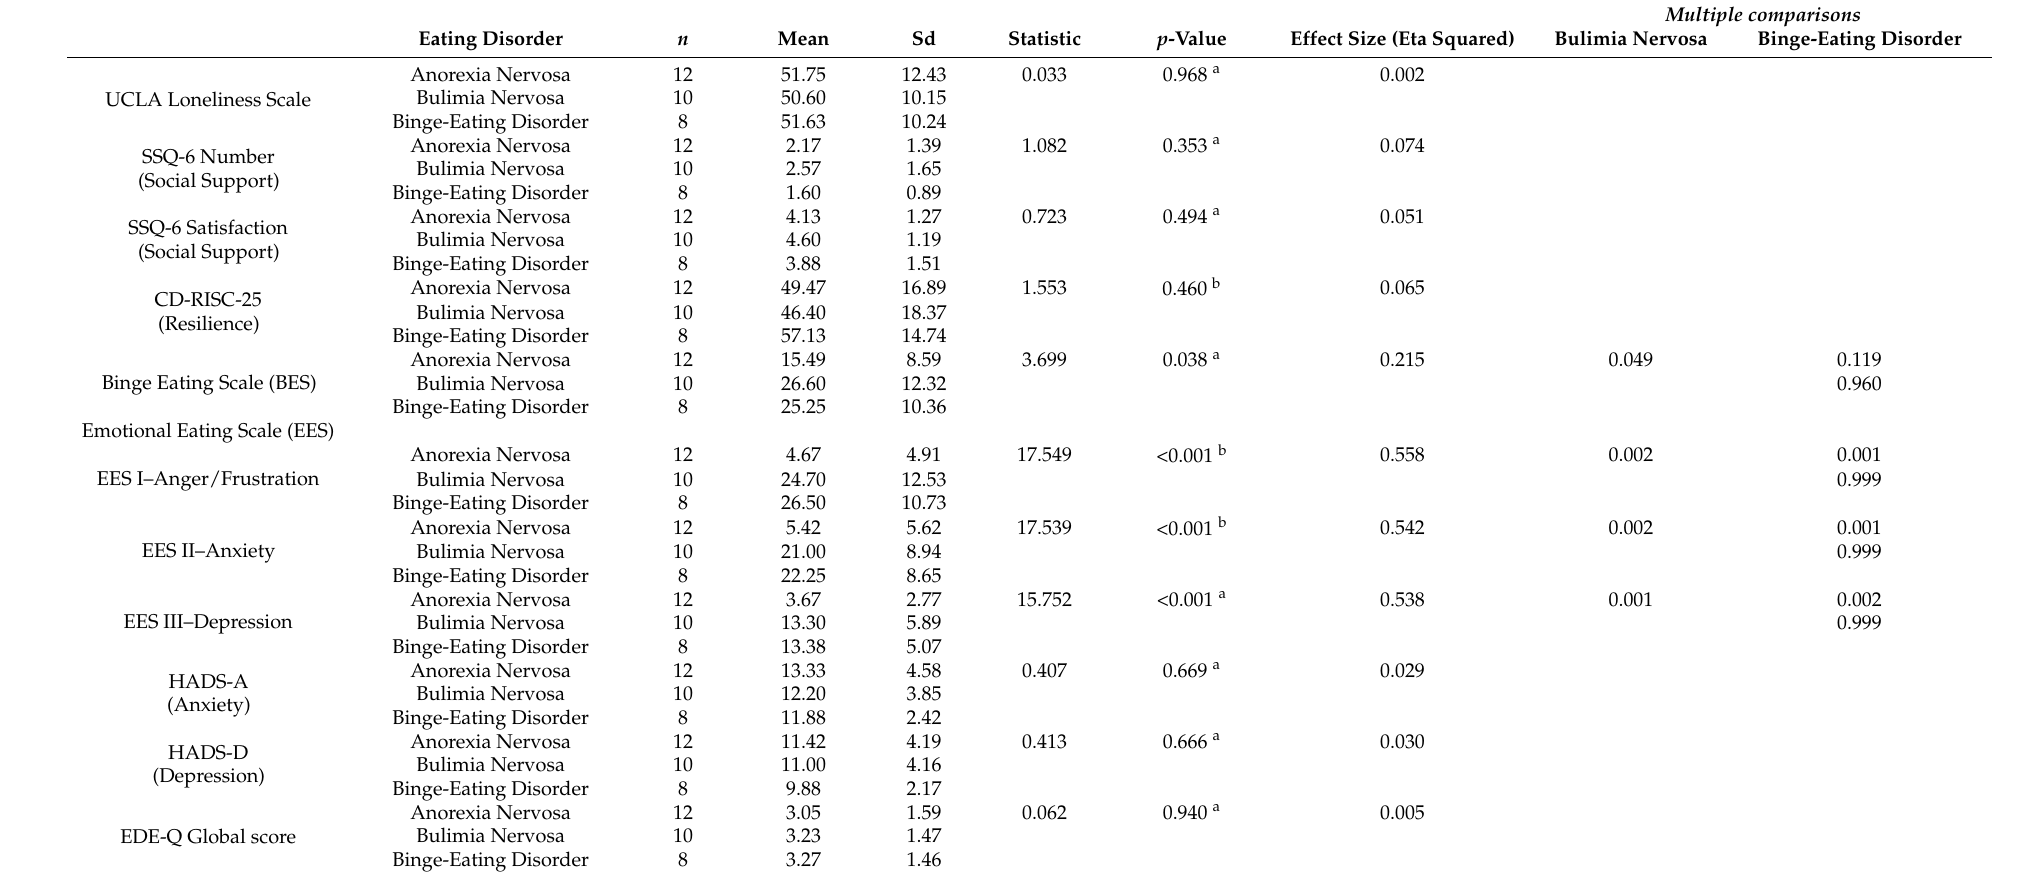
Table 3. Comparisons between ED patients based on their diagnosis for the variables: loneliness, social support, resilience, binge eating, emotional eating, anxiety, depression, and ED